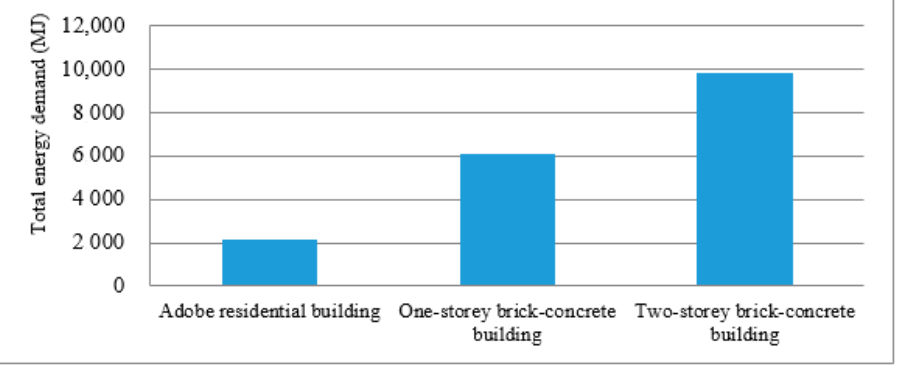
Figure 14. Total energy demand in the process of waste disposal. Energies 2020 , 13 , x FOR PEER REVIEW